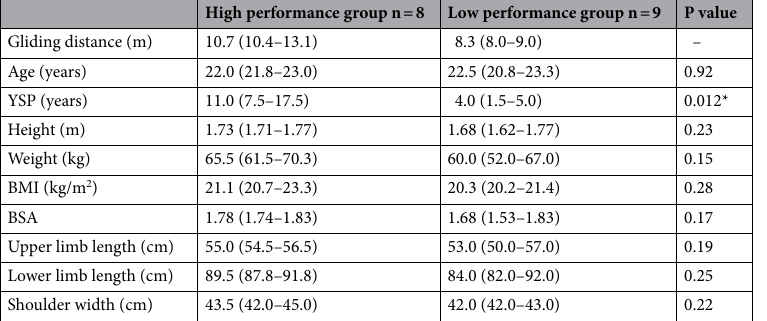
Table 1. Participant characteristics. All data are presented as medians with interquartile ranges. YSP the years of swimming practice, BMI body mass index, BSA body surface area. *p <